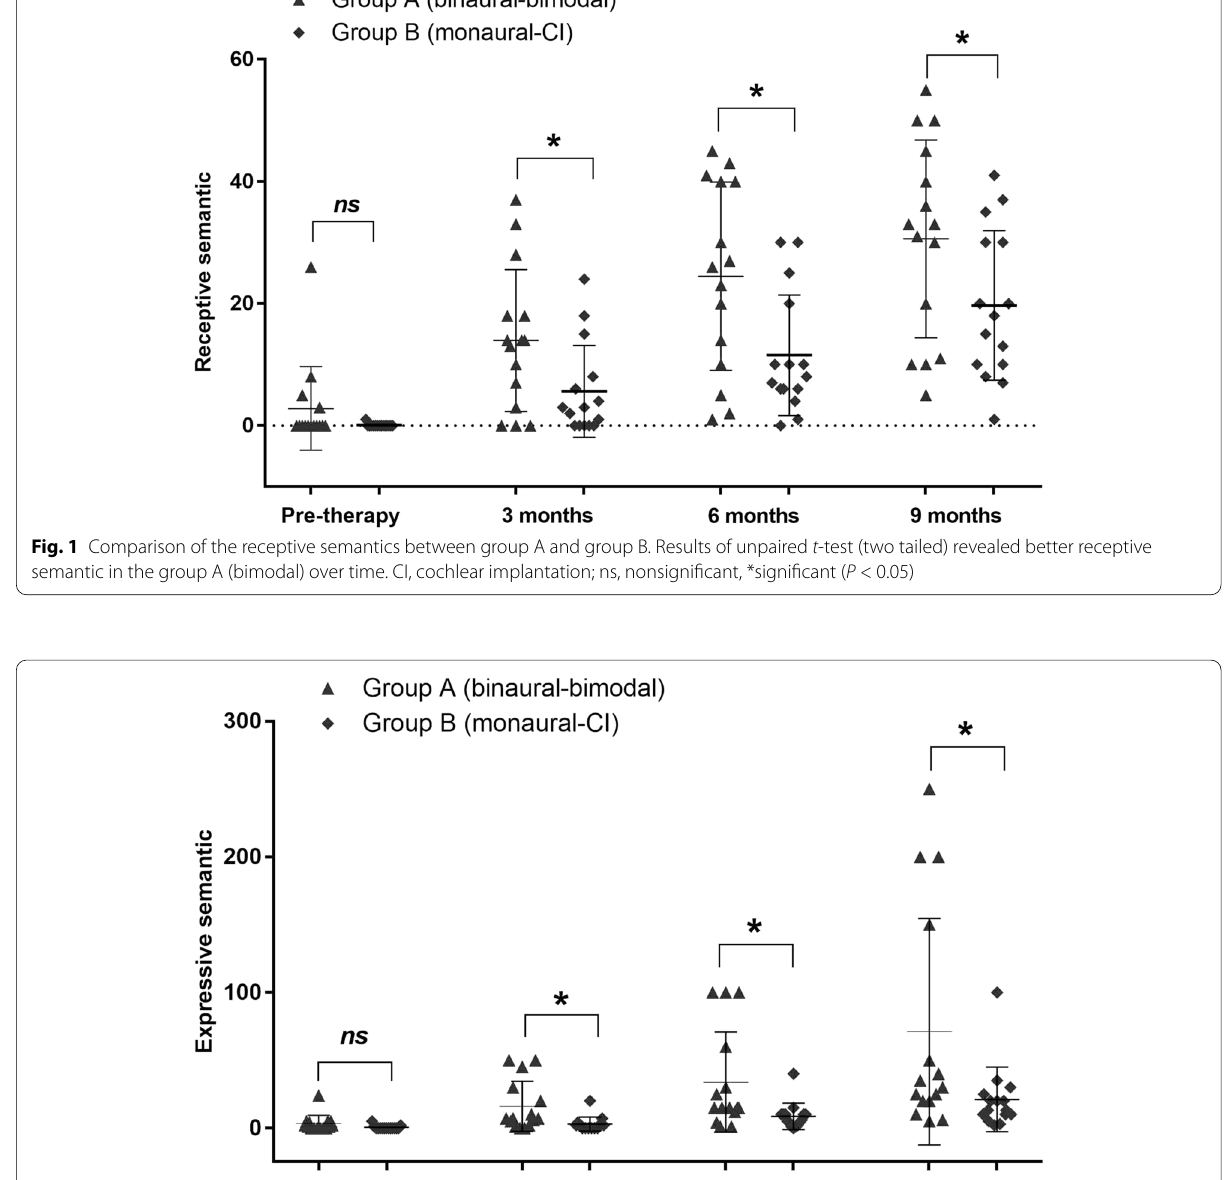
0.02, 0.009, 0.036, and 0.016, respectively (Fig. 4). Speech between the two groups before therapy ( P 0.14). Over = intelligibility showed no difference between both groups time, word class revealed significant differences between before therapy ( P 0.07). The speech intelligibility score the two groups in 3-, 6-, and 9-month evaluations in = favor of group A: P 0.025, 0.042, and 0.03, respectively = (Fig. 3). The mean length of sentences (MLU) showed significant differences between the two groups before 0.003, 0.006, and 0.028, respectively (Fig. 5). therapy and in 3-, 6-, and 9-month time-points: P =